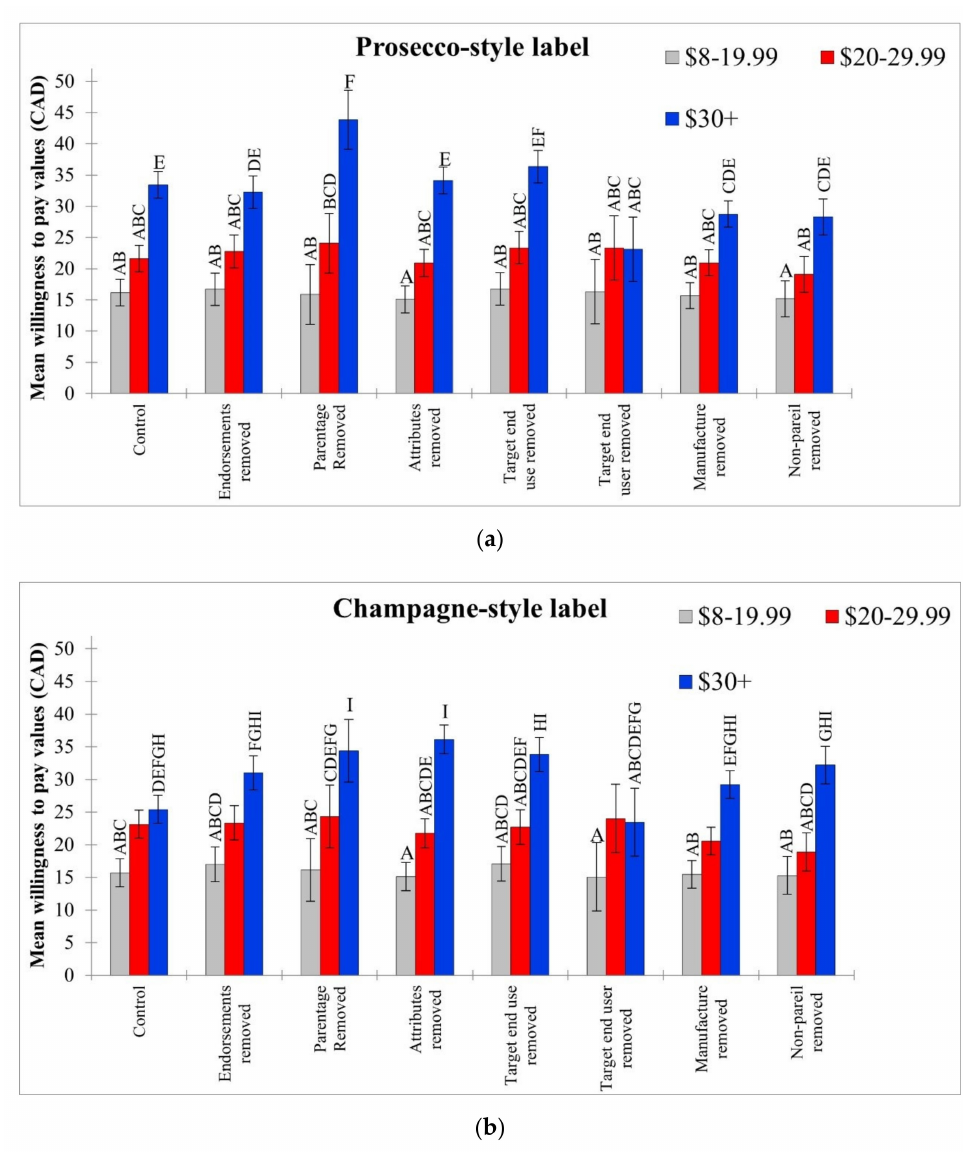
Figure 4. Willingness to pay (CAD, n = 566) +/ − SE for sparkling wine—interaction between label treatments and the amount typically spent per bottle of sparkling wine. Results for ( a ) Prosecco-style wine and ( b ) Champagne-style wine. Letters above bars represent significantly different groups across all label treatments (Tukey’s (HSD 0.05 ) following two-way ANOVA. Respondents who consider themselves as having a high sparkling wine knowledge are willing to pay more for the Prosecco-style wine in several label conditions, as compared to consumers who consider themselves as having a low–medium knowledge ( F (14,540) = 1.95, p = 0.020), with the same pattern observed for Champagne-like wine ( F (14,542) = 2.06, p = 0.013; Figure 5). The difference is often non-trivial; for instance, approximately 47% more in the case of the Prosecco control